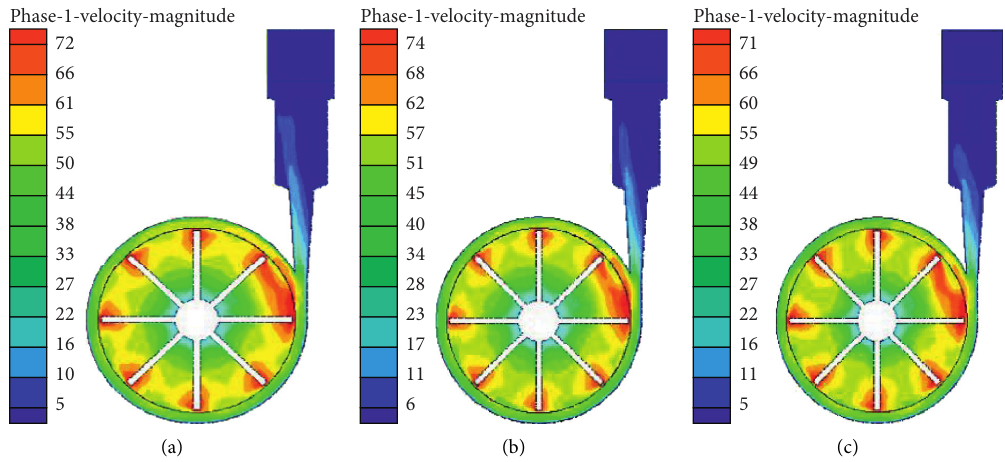
Figure 11: Liquid phase velocity distribution of different particle sizes. (a) D � 0 . 01. (b) D � 0 . 1. (c) D � 0 . 2.